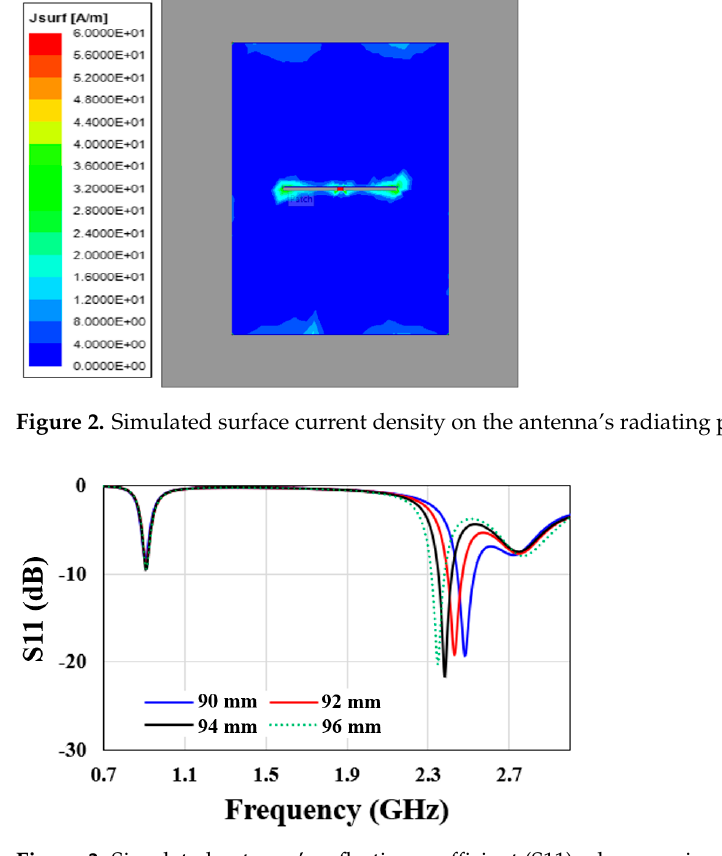
Figure 3. Simulated antenna’s reflection coefficient (S11) when varying the patch width.